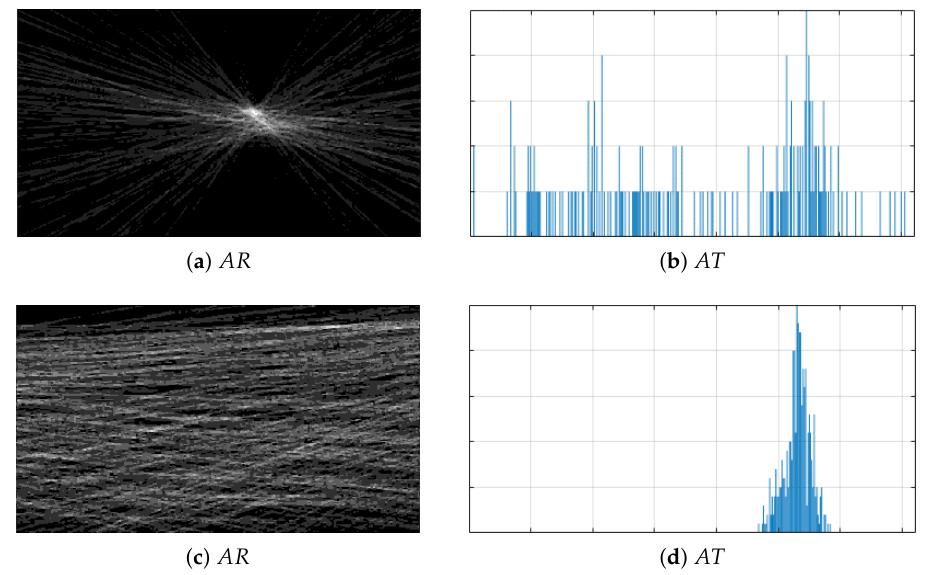
Figure 8. Accumulators: ( a ) AR in rotation, ( b ) AT in rotation, ( c ) AR in recovery, ( d ) AT in